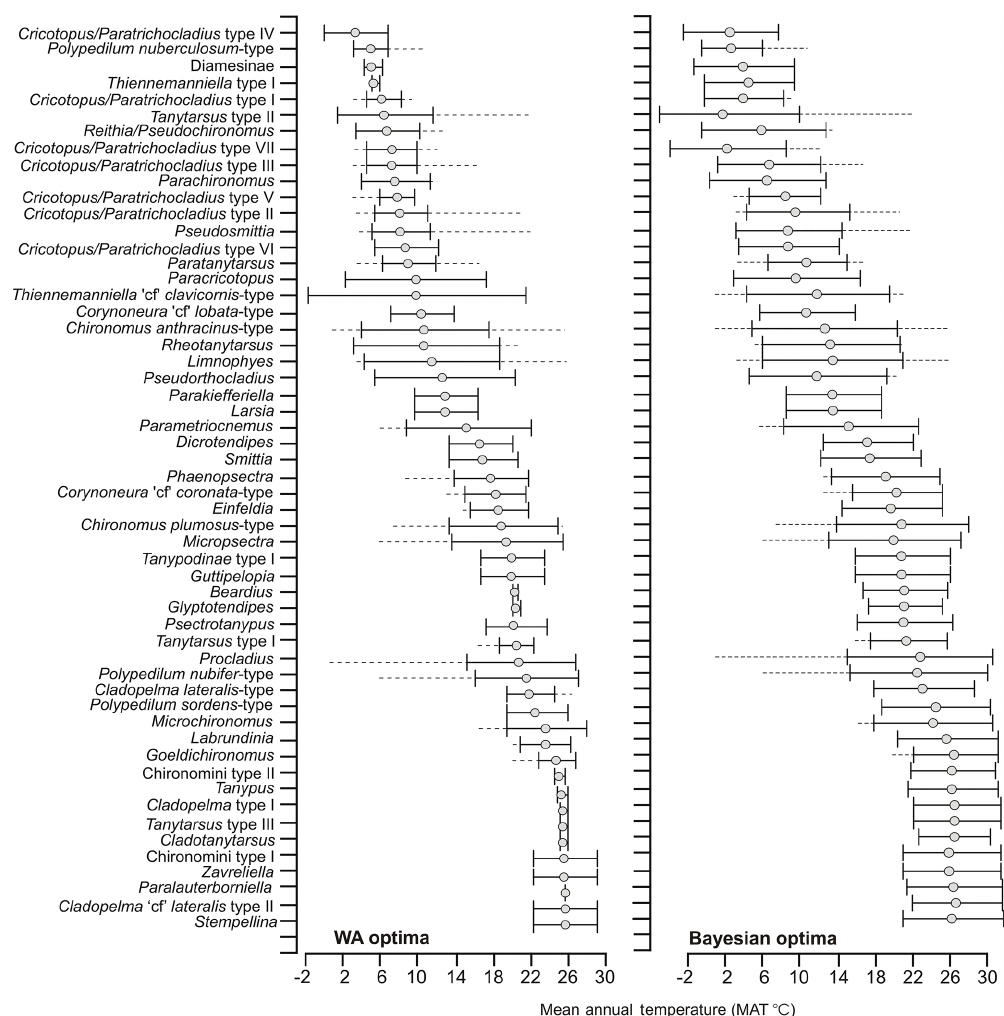
Figure 5. Weighted average and Bayesian optima (solid grey circles) and tolerances (thick lines) of the 55 chironomid taxa included in the calibration data set, and MAT range (dashed lines). Taxa are organized by WA temperature optima from cold to warm. Table 4. Summary of the performance statistics of chironomid-based MAT( ◦ C) inference models developed using classical and Bayesian methods based on leave-one-out cross validation and allowing weighted averaging inverse and classical (WAinv, WAcla), with and without tolerance down-weighting (TOL), weighted averaging partial least squares (WA-PLS), coefficient of determinant between predicted and ), and root mean squared error of prediction (RMSEP jack ) as percentage of the observed ( r 2 jack